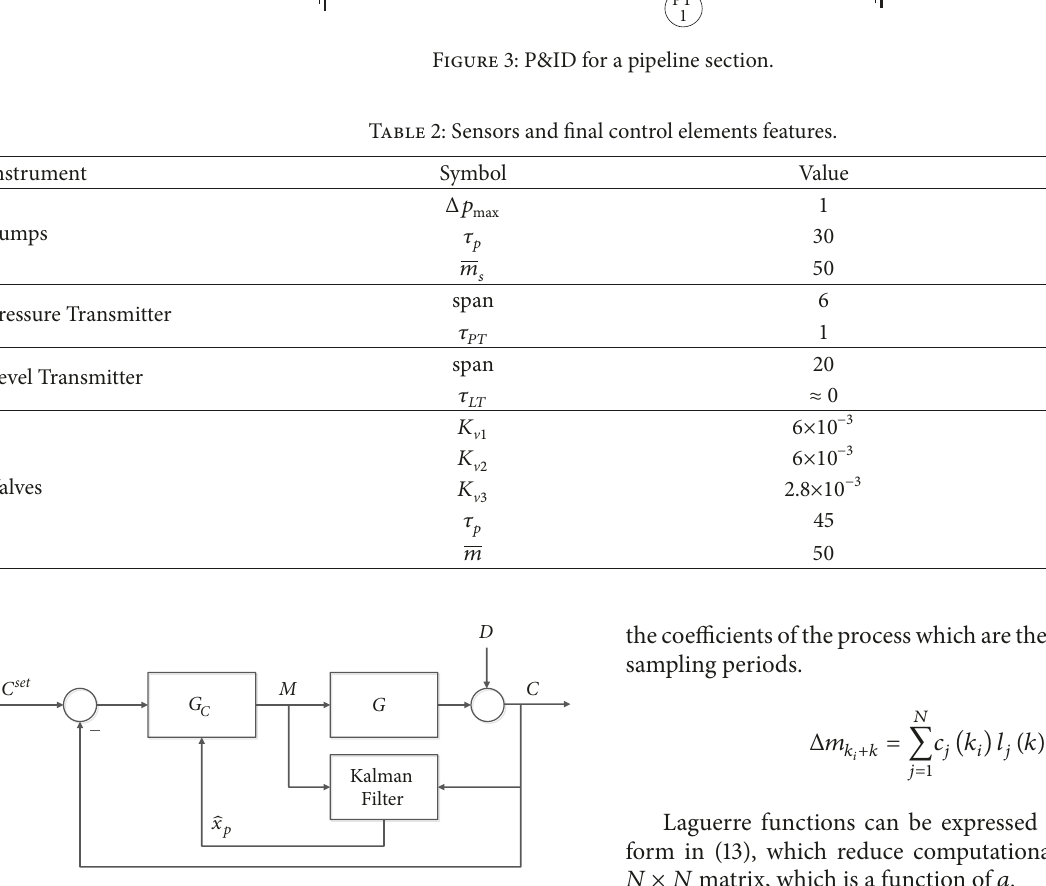
Figure 4: A general block diagram of the implemented